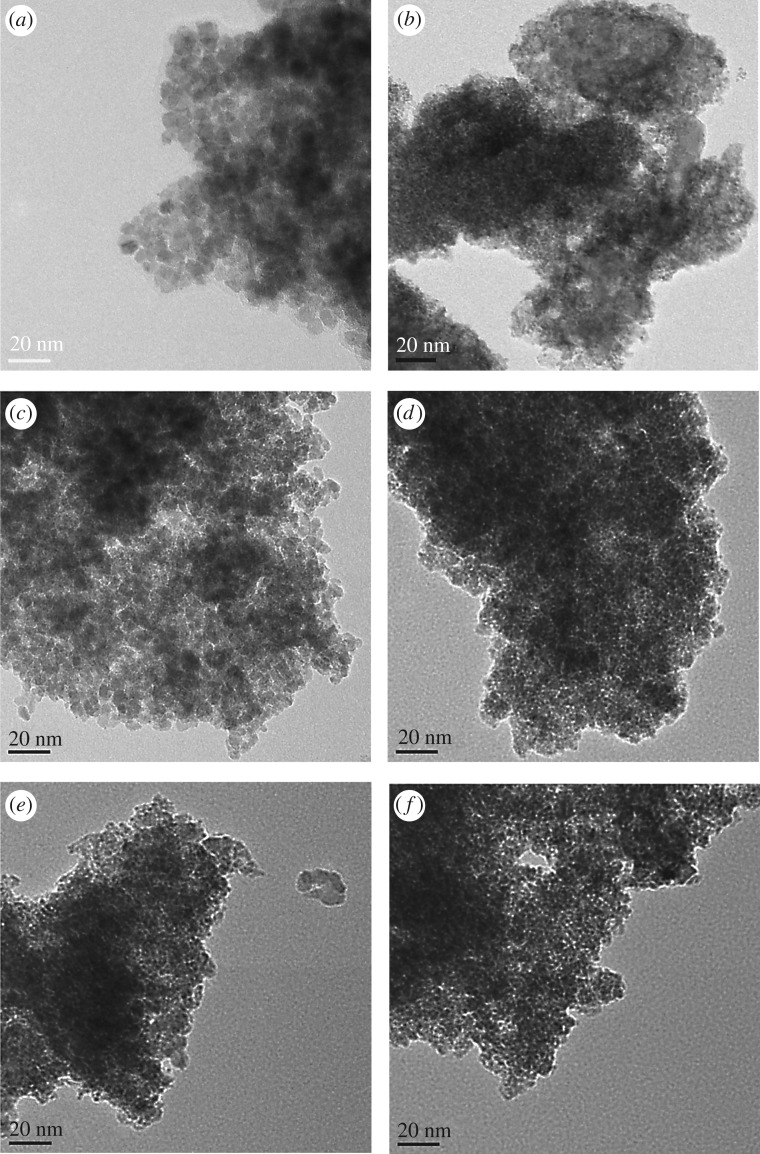
TEM images of (a) unsupported IrO2, (b) SnO2, (c) 40IrO2/SnO2 (d) 40IrO2/Co0.1Sn0.9O2, (e) 40IrO2/Co0.2Sn0.8O2 and (f) 40IrO2/Co0.3Sn0.7O2.